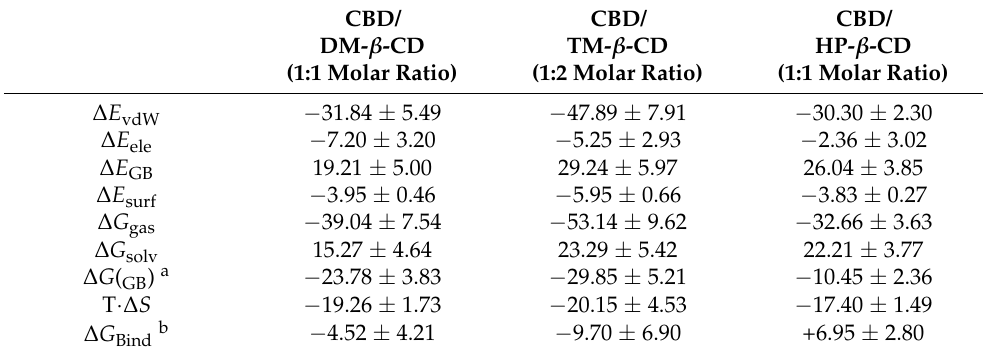
Table 3. Binding free energies and their standard deviations (kcal/mole) resulting from MM/GBSA analysis of the inclusion compounds of CBD/DM- β - CD (1:1), CBD/TM- β - CD dimer (2:1), and CBD/HP- β - CD (1:1).